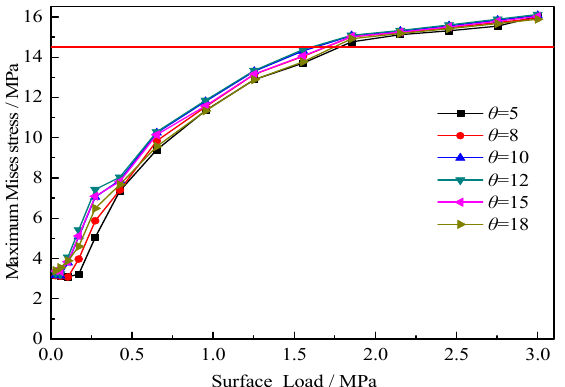
Figure 21. Maximum von Mises stress in HDPE pipe with various defect widths.